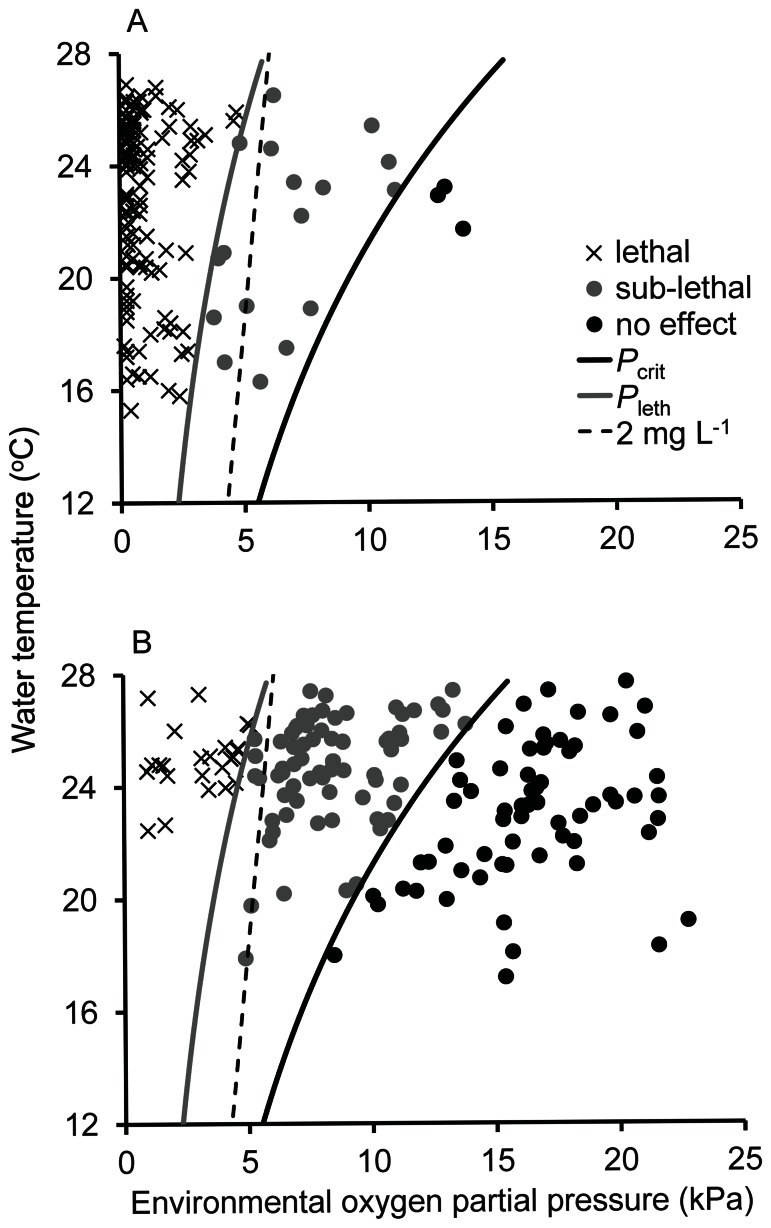
Model predicting the influence of hypoxia on Acartia tonsa applied to data from Chesapeake Bay.Each data point is a measurement of temperature and oxygen partial pressure between June and September in the sub-pycnocline Chesapeake Bay. Points are coded to indicate predicted lethal, sub-lethal, or no effect on Acartia tonsa. The temperature and oxygen measurements used were taken monthly from 1986 to 2011 as part of Chesapeake Bay Program (CBP) monitoring (http://www.chesapeakebay.net/data). Thresholds for critical (P
crit) and lethal (P
crit) oxygen partial pressures are also indicated, as is the traditionally hypoxic 2 mg L−1 oxygen facet. Data are from (a) a region with severe summer hypoxia (CBP station CB4.3C), and (b) a region outside of the extent of severe hypoxia (CBP station CB6.1C).